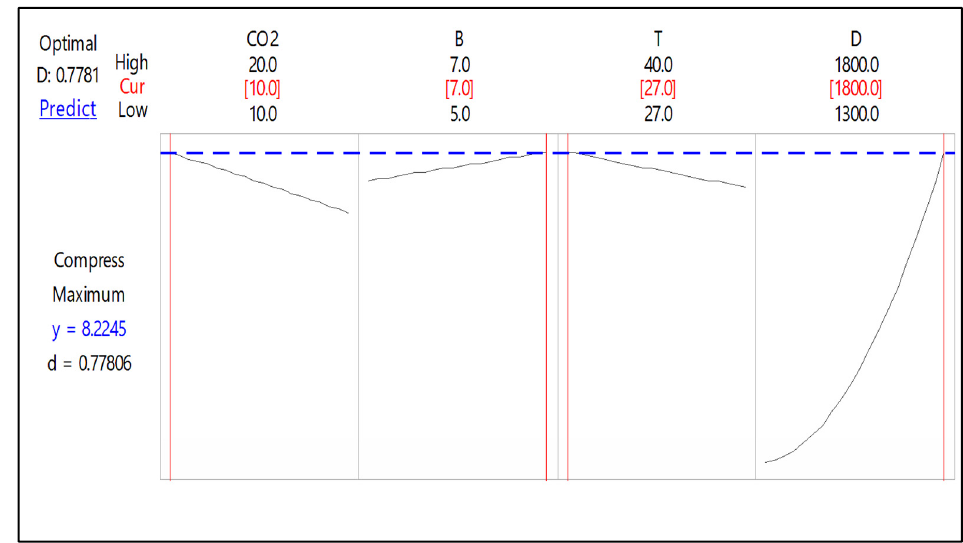
Figure 6. Optimization plot for the compressive strength of B-FCB.